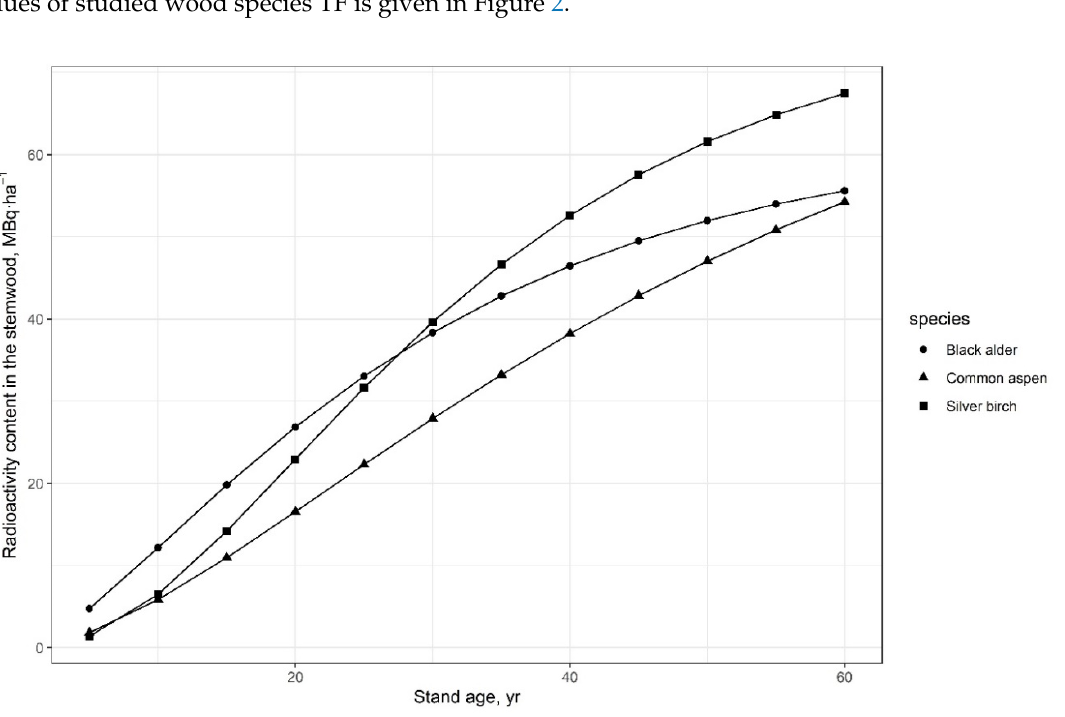
Figure 2. Dependence of the 90 Sr activity stock in stemwood (at 40 kBq · m − 2 in soil and site index I) on various age of forest stands.